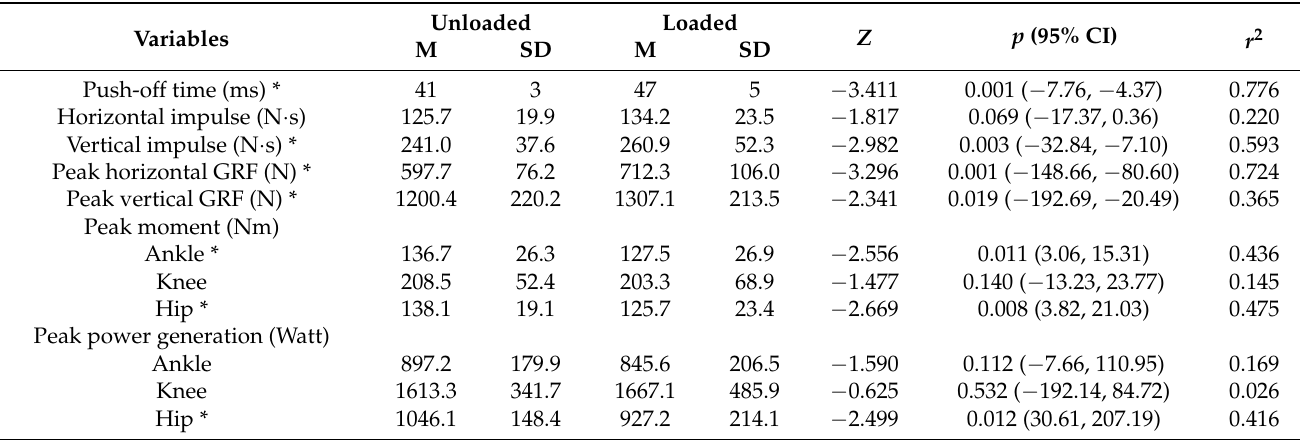
Table 2. Kinetic variables in standing broad